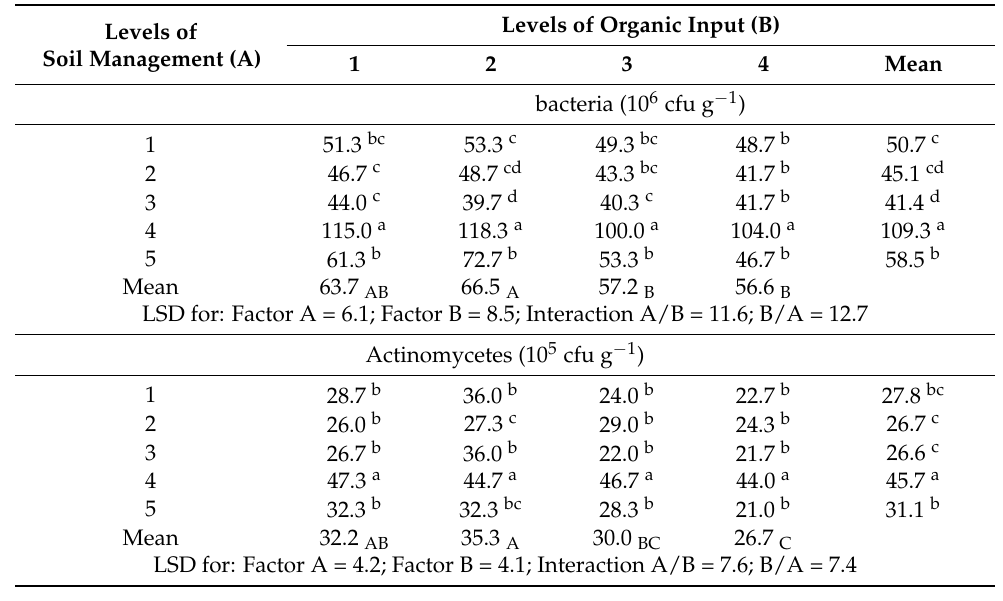
Table 1. Total number of bacteria, actinomycetes, and fungi in the soil, depending on the